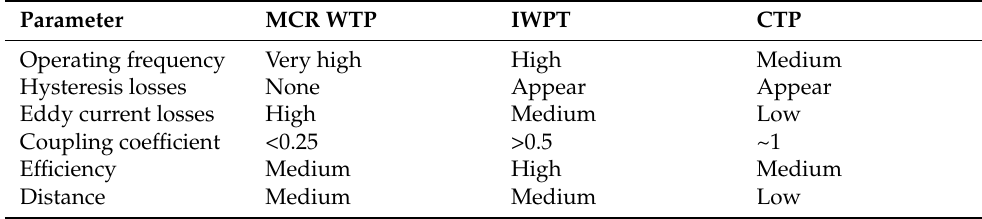
Table 1. Comparison of parameters of various IPT technologies [56].